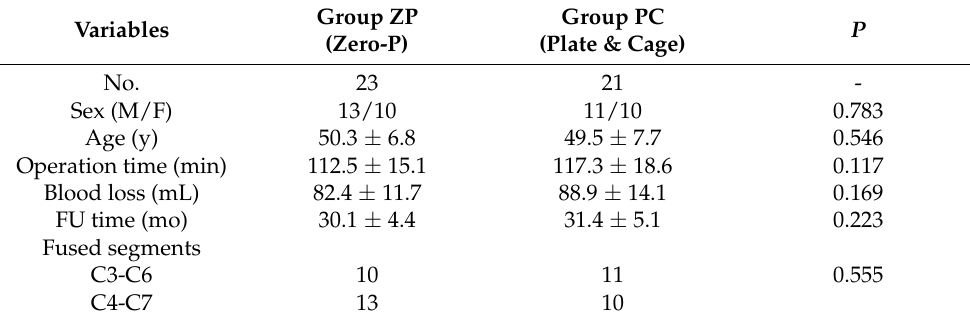
Table 2. Demographics of